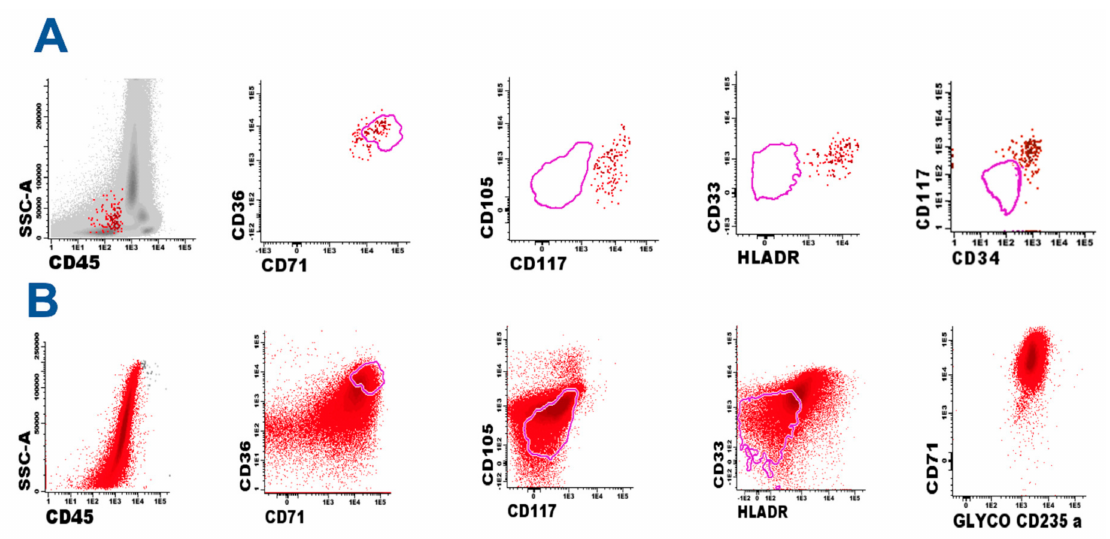
Figure 2. ( A ) Identification of minor population of erythroid leukemic cells (red dots), cluster of differentiation 45 − (CD45 − ), CD34 +/ − , CD36 + , CD71 + with abnormal expression of CD105, CD117, Histocompatibility Leukocyte Antigen-D Related (HLADR), and CD33. The correct